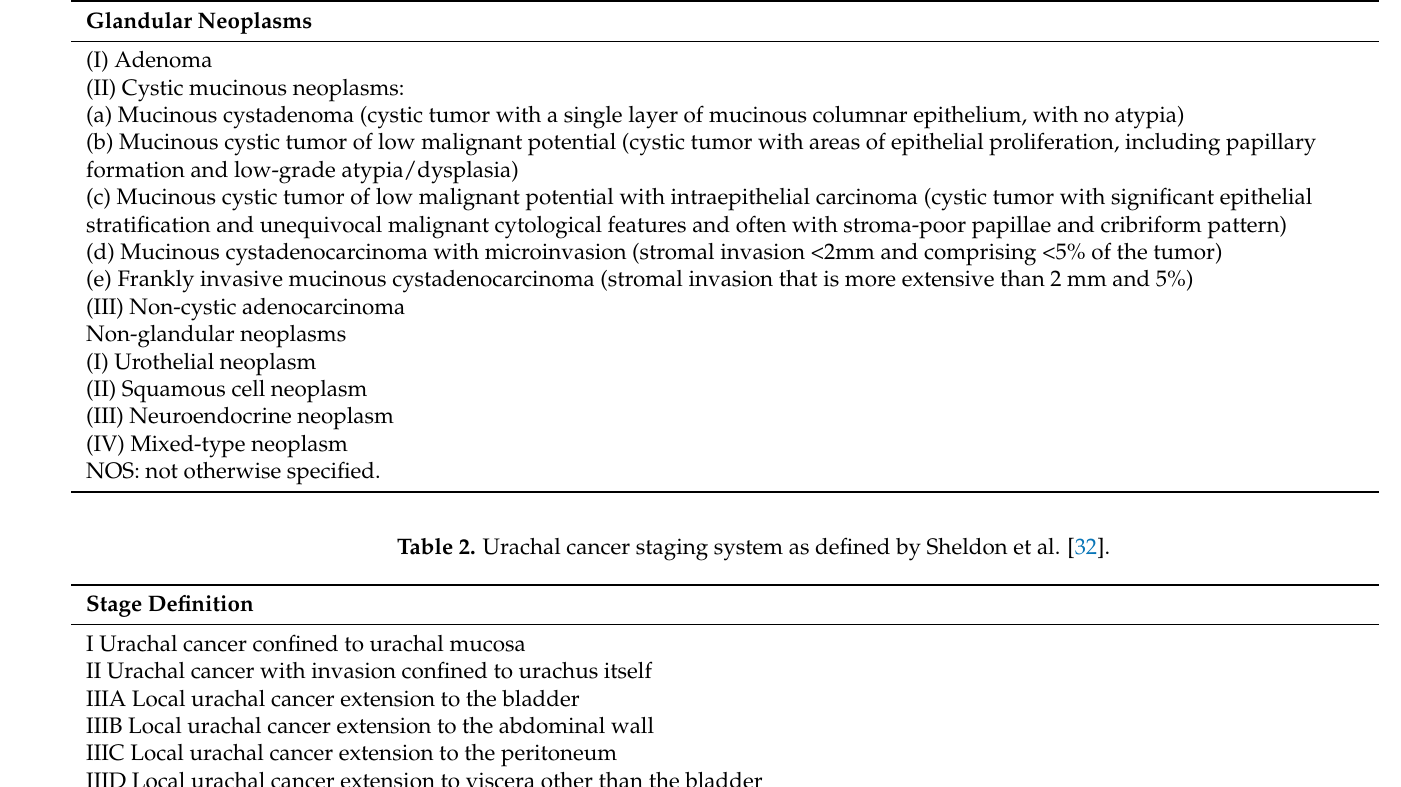
Table 1. Classification of epithelial neoplasms of urachal origin with emphasis on the cystic mucinous